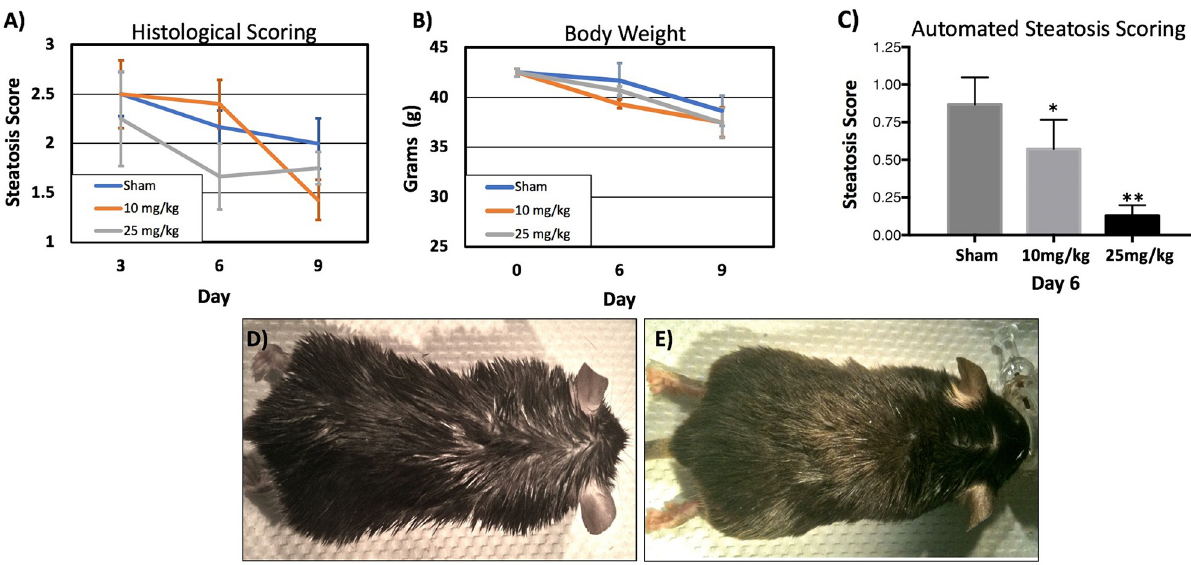
Fig 8. 500199 attenuates hepatic steatosis and improves greasy coat phenotype in high fat diet fed mice but has no effect on body weight. Histological scoring of steatosis in H&E stained whole liver sections (A) and body weight in grams (B) of HFD-fed mice with and without 500199 administration at 10 or 25mg/kg by I.P for 9 days. Steatosis scoring using automated image analysis pipeline for the identification of macro- and micro- steatosis in H&E stained whole liver sections (C). Tabulated lipid droplet statistics for sham vs. 500199 treated liver tissues on Day 6. � indicates statistically significant differences p < 0.02 �� indicates statistically significant differences p < 0.0001. (E) Greasy coat phenotype in 20-week old HFD-fed mice (D) and clearing of greasy coat phenotype in HFD-fed mice treated with 500199 (E).